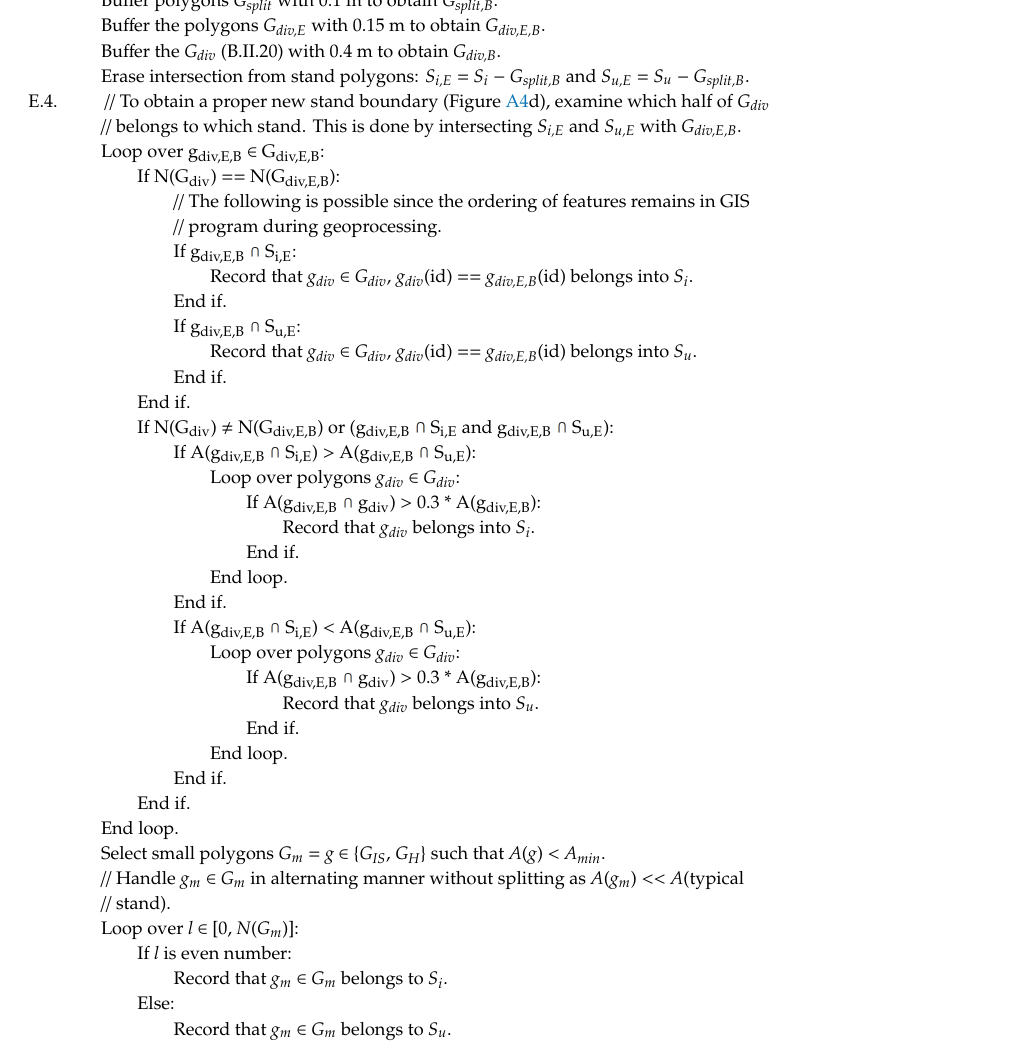
Bu ff er polygons G split with 0.1 m to obtain G split,B . Bu ff er the polygons G div,E with 0.15 m to obtain G div,E,B . Bu ff er the G div (B.II.20) with 0.4 m to obtain G div,B . Erase intersection from stand polygons: S i,E = S i − G split,B and S u,E = S u − G split,B .